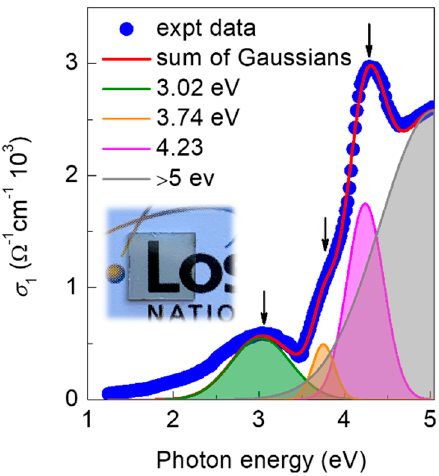
Figure 4. Spectroscopic ellipsometry measurement of the optical conductivity of YCO film, where the positions of all Gaussian peaks are shown with arrows. The inset shows the photograph of a 32-nm YCO film sample grown on a two-side-polished 5 × 5 × 0.5 mm 3 STO (001) substrate.